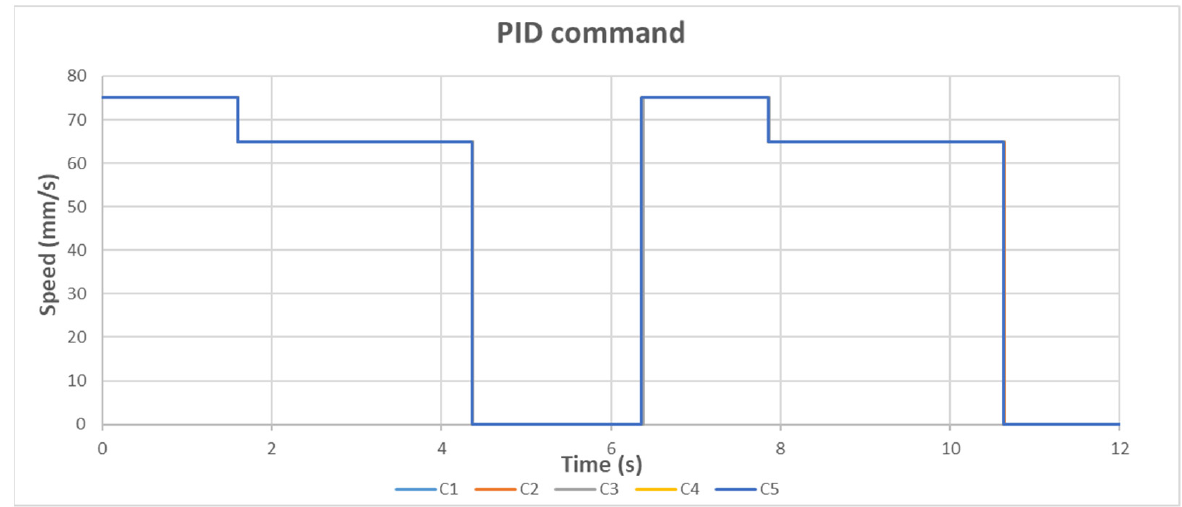
Figure 11. Event-based control speed output in regular cases.